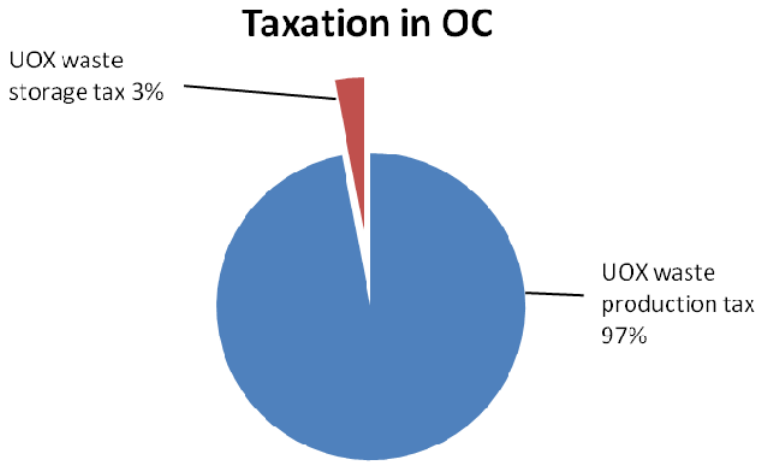
Figure 4. Each tax contribution to the total taxation in the open cycle .